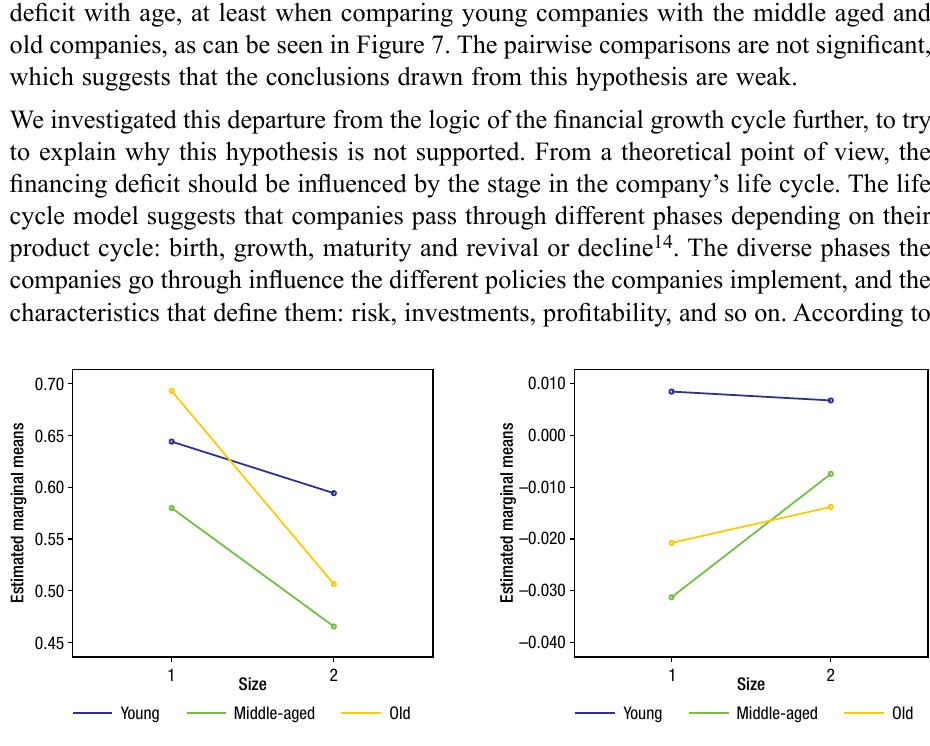
Fig. 6. RELAT ST FIN DEBT Variable Fig. 7. FINANCING DEFICIT